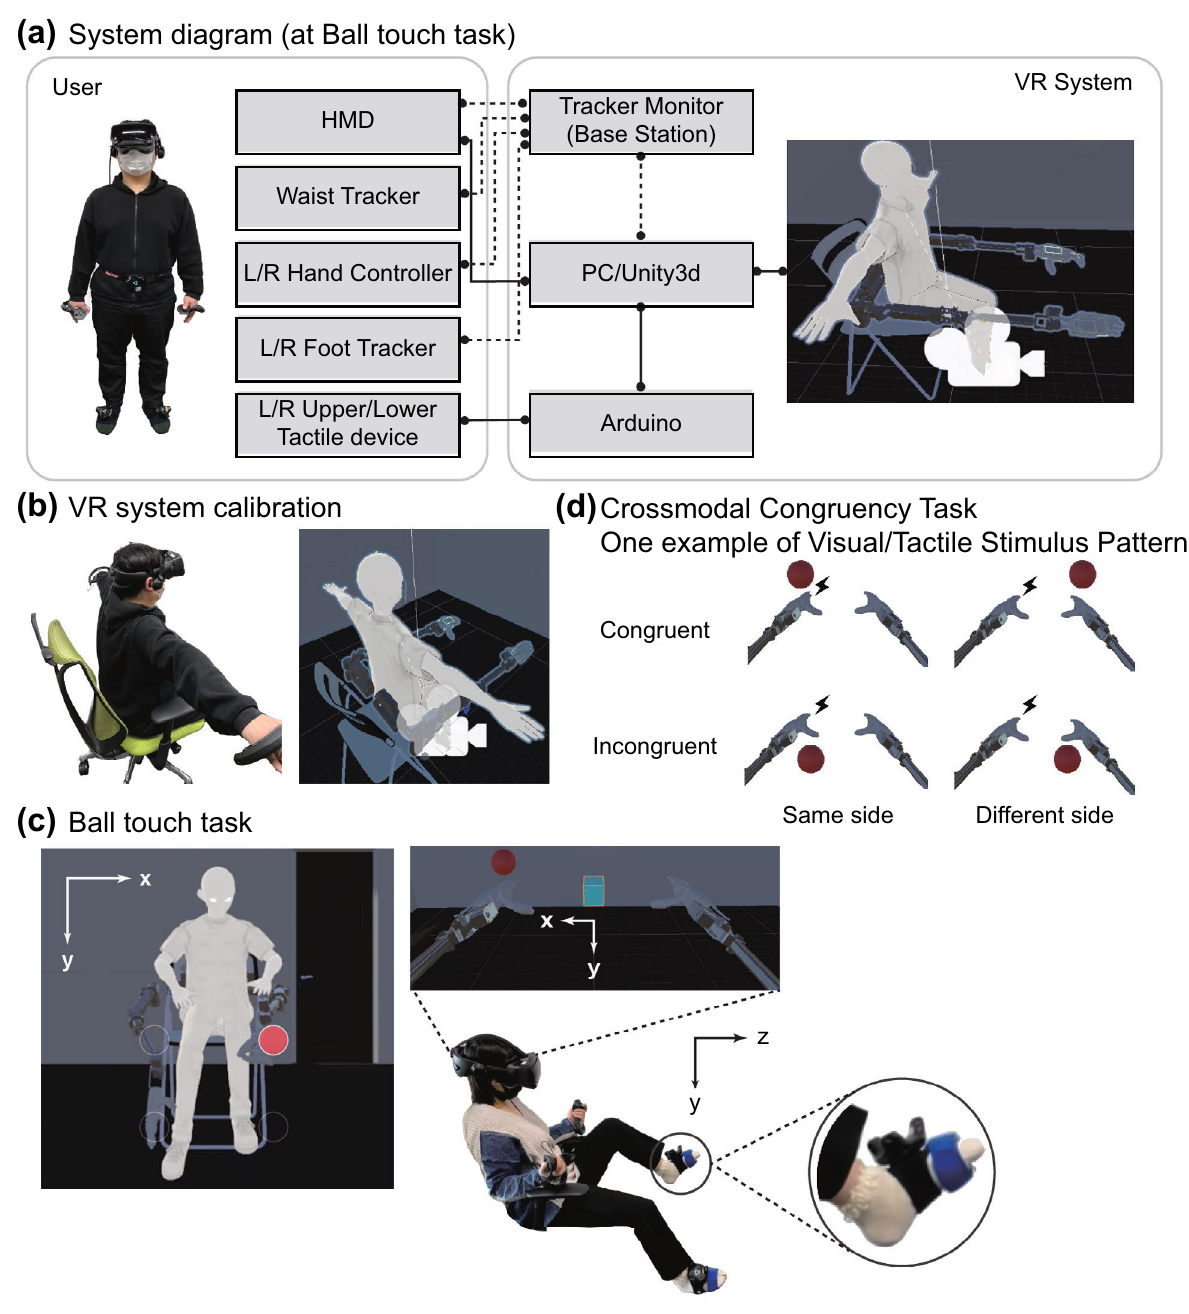
Figure 1. ( a ) The system diagram depicts the components of the system used in this experiment and their relationships. The solid line indicates a wired connection, and the dotted line indicates a wireless connection. ( b ) VR system calibration shows the correspondence between the real space and the VR space. ( c ) The first- and third-person perspectives of a ball touching task are shown. When the participant touches the ball, it vibrates to the location corresponding to the position of the innate foot. ( d ) An example of the visuotactile stimulus condition is a crossmodal congruency task (CCT). In this example, the tactile stimulus was transmitted to the back of the left foot, and the visual stimulus was presented to the back of the hand and palm of the left and right robot